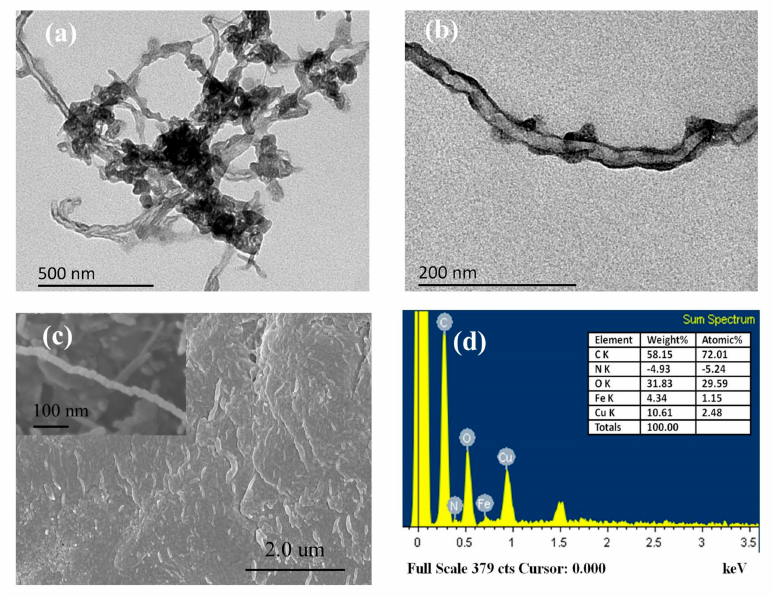
Figure 3. ( a ) TEM images of Fc-CHIT / CNT@Cu ( b ) under high magnification; ( c ) SEM images of Fc-CHIT / CNT@Cu and ( d ) energy dispersive X-ray